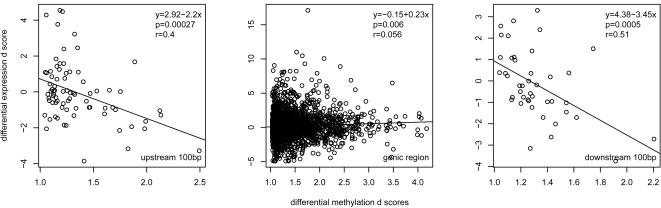
Correlation between CG Methylation Polymorphisms and Differential Gene Expressions.Differential gene expression d scores (y-axis) were linear regressed against d scores of genotype×enzyme effect (x-axis) for features within 100 bp upstream from transcriptional start (left panel), genic region (middle panel) and 100 bp downstream from transcriptional stop (right panel).